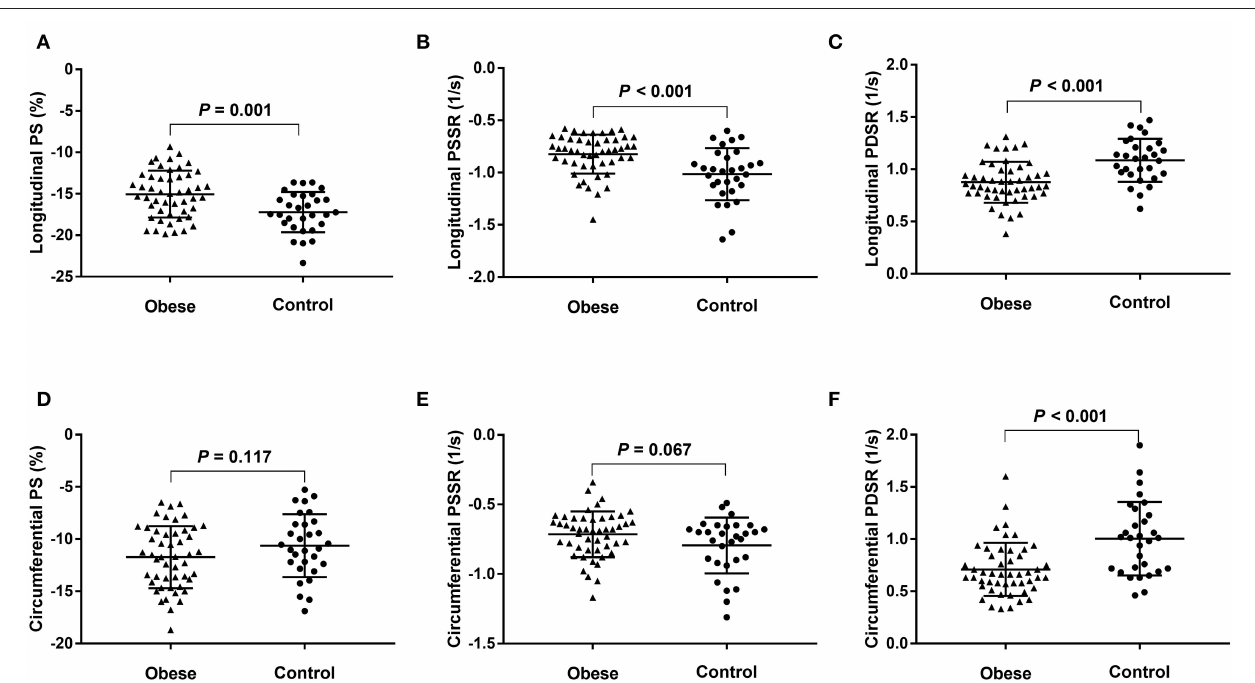
FIGURE 2 | Dot plots comparing the right ventricular strain parameters of patients with obesity and normal controls. (A) Longitudinal PS, (B) longitudinal PSSR, (C) longitudinal PDSR, (D) circumferential PS, (E) circumferential PSSR, and (F) circumferential PDSR. PS, peak strain; PSSR, peak systolic strain rate; PDSR, peak diastolic strain